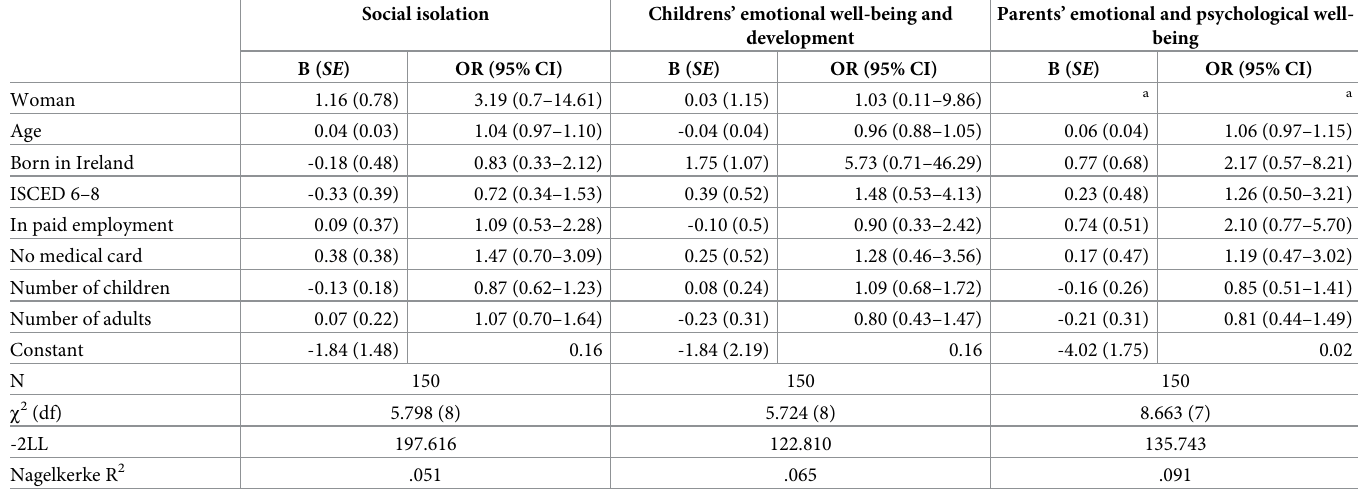
Table 5. Logistic regression analyses for demographics predicting difficulties related to the Covid-19 pandemic restrictions. Social isolation